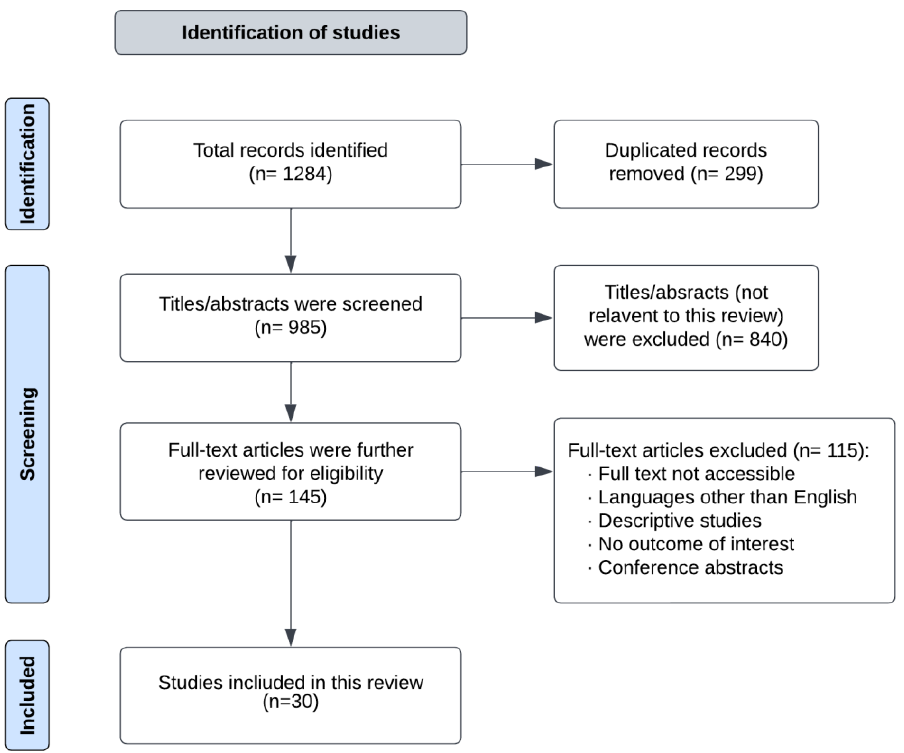
Figure 1. Flow chart of included and excluded studies.